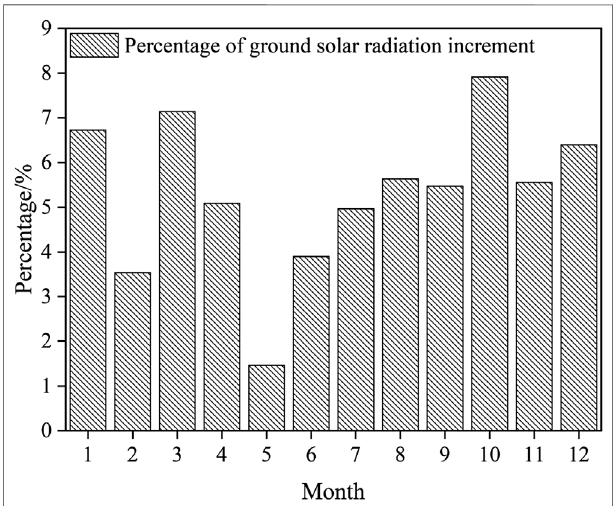
FIGURE 6 | Percentage of simulated ground solar radiation increment caused by emission reduction from 2015 to 2021.